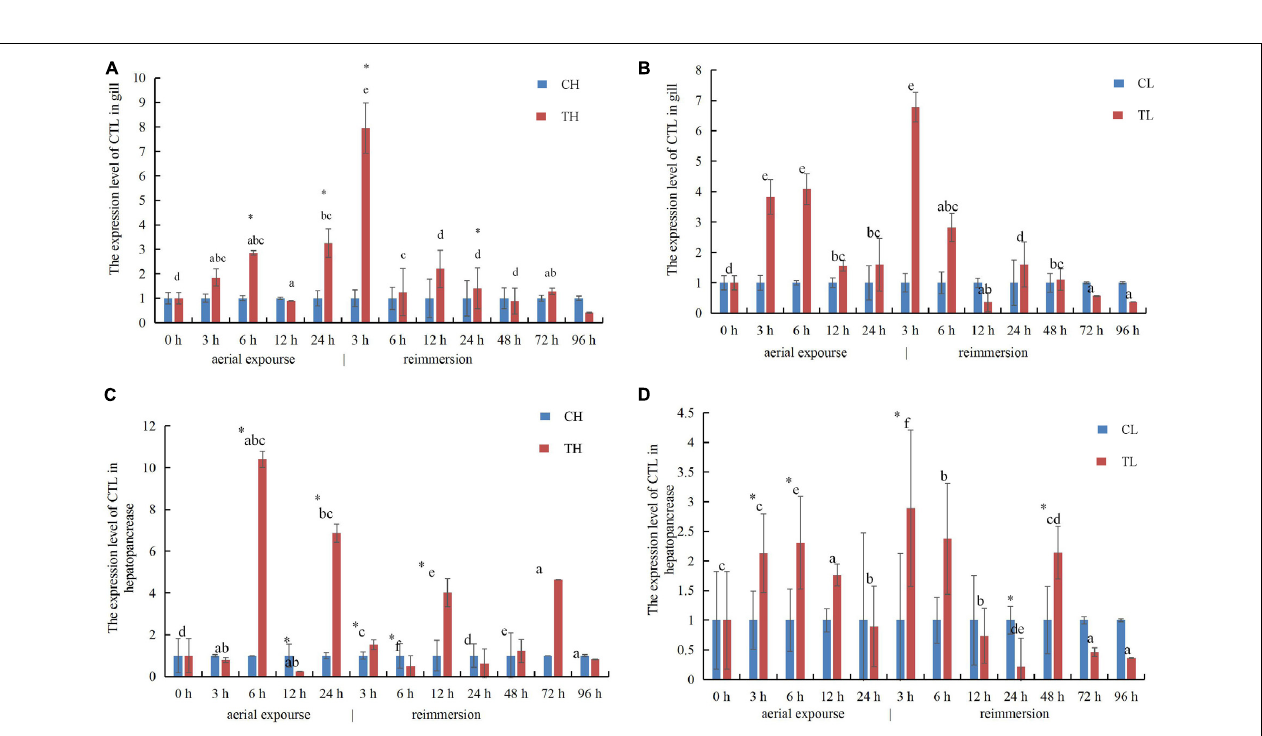
FIGURE 10 | The expression analysis of RpCTL in the gill of R. philippinarum under aerial exposure and reimmersion at high (A) and low temperature (B) . The expression analysis of RpCTL in the hepatopancreas of R. philippinarum under aerial exposure and reimmersion at high (C) and low temperature (D) .